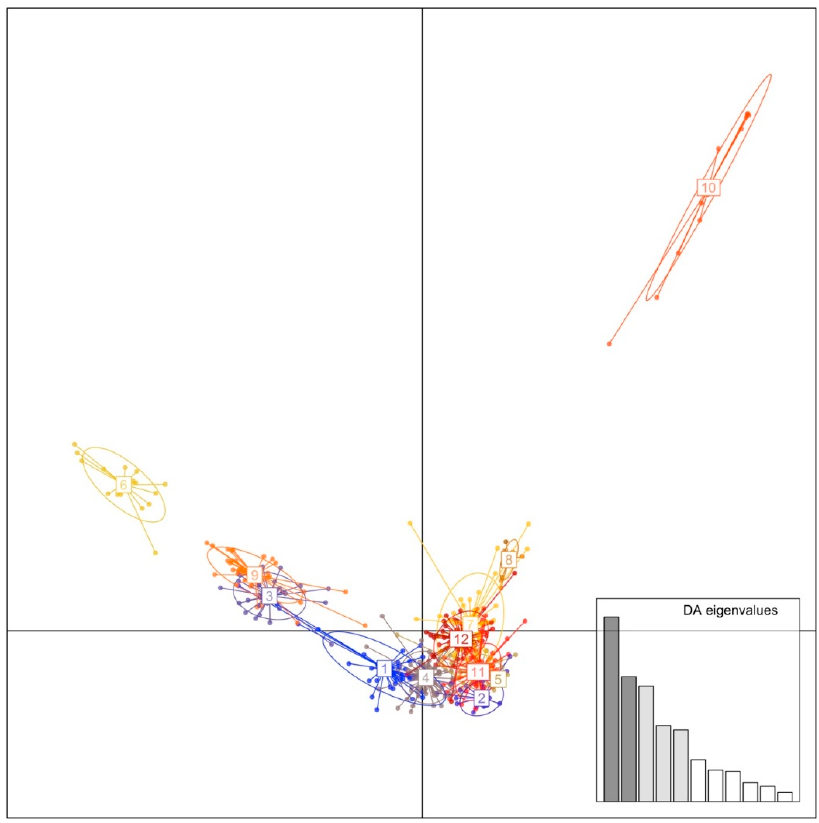
Figure 4. Scatter plot of DAPC showing the first two principal components for K = 12. Dots represent accessions while the ellipses represent the 12 groups. Eigenvalues of the analysis are also displayed.